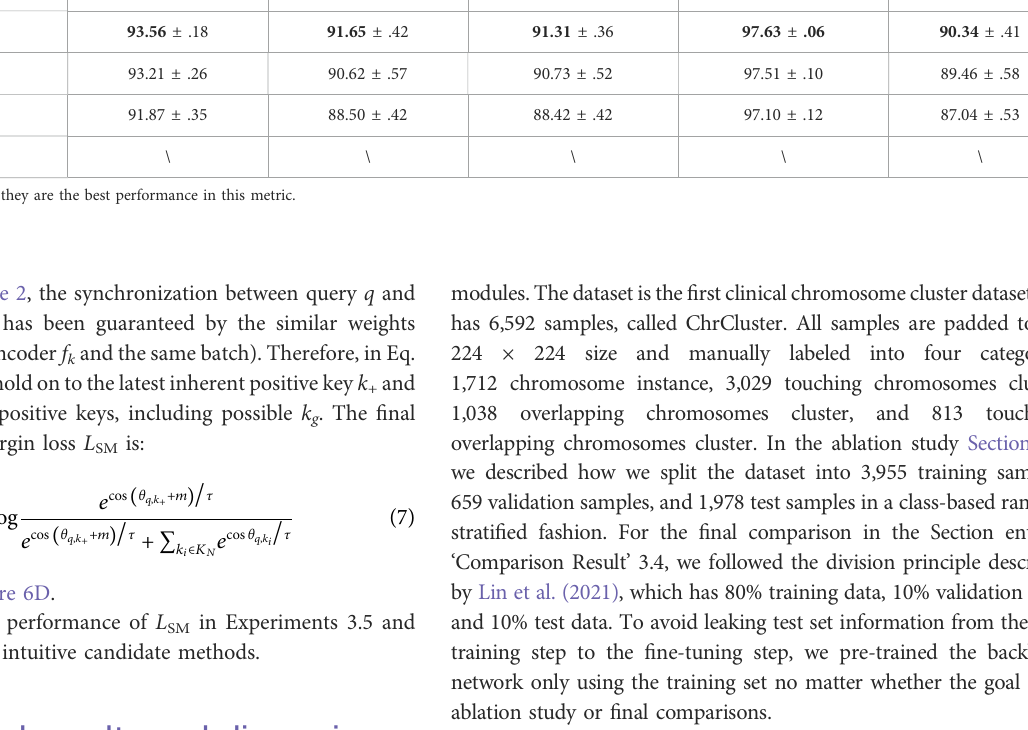
The bold values represent that they are the best performance in this metric.